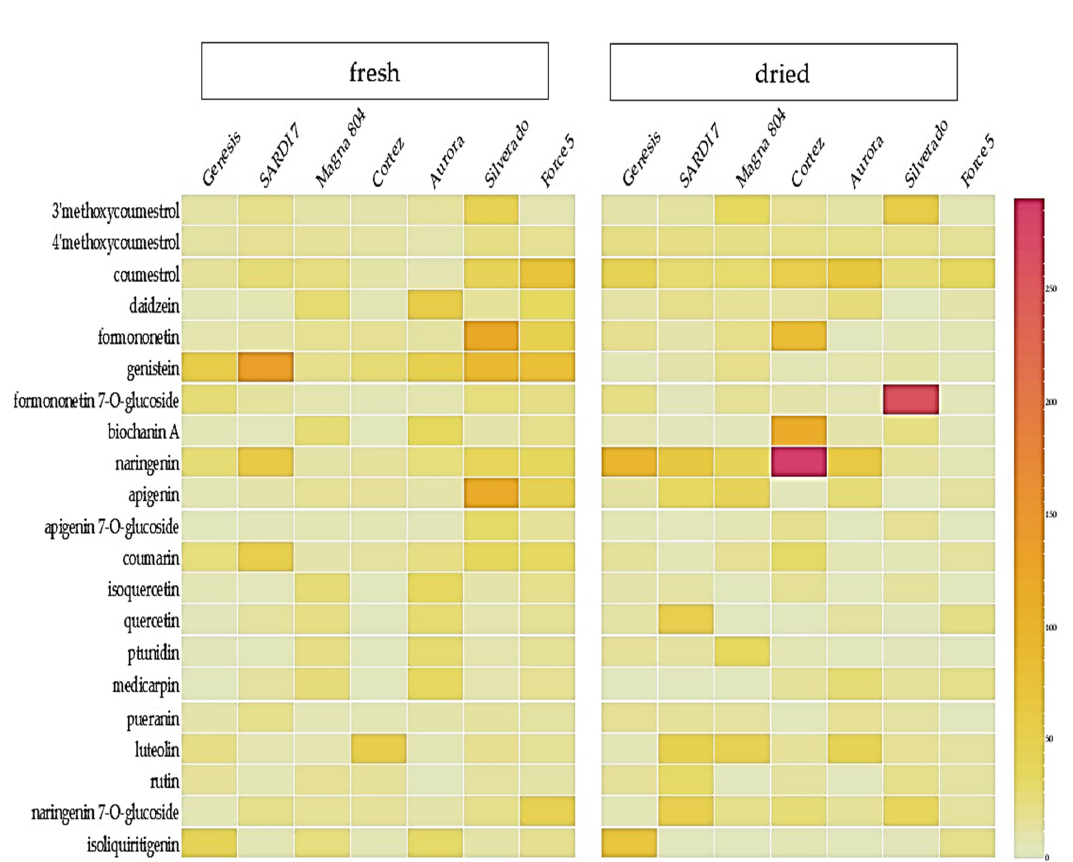
Figure 4. A visual representation of a 3D PCA (principal component analysis) of the molecular fea- tures characterized in shoot samples collected from seven cultivars of lucerne using UHPLC-QToF- MS in negative ion mode. Component 1 (X-Axis), 2 (Y-Axis) and 3 (Z-Axis) contributed to the sepa- ration by 48.63%, 10.82% and 14.05%, respectively. 2.2. Quantification of Phytoestrogens in Lucerne Cultivars Six key phytoestrogens, coumestrol, 3 ′ methoxycoumestrol, 4 ′ methoxycoumestrol, daidzein, formononetin and genistein, previously reported in legumes and other broad- leaf pasture crops in the literature, were identified in all seven cultivars investigated (Ta- ble 1, Figure S1).